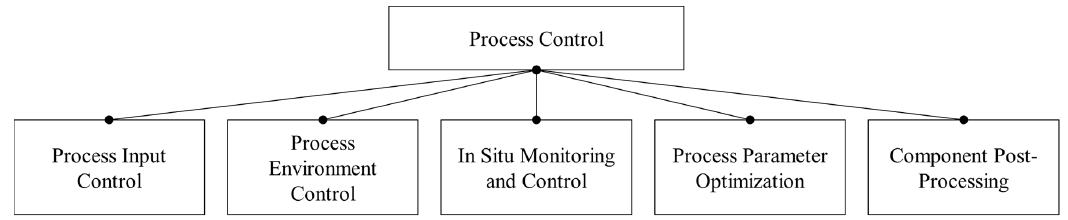
Figure 8. Process control and post-processing categories.